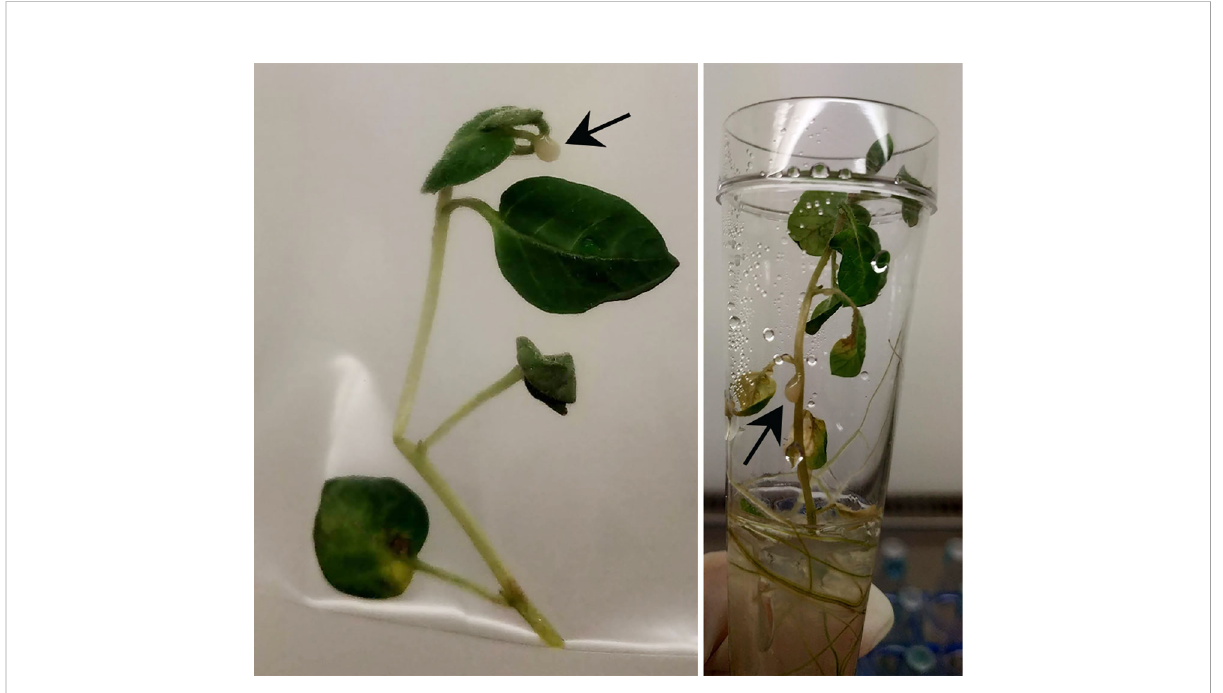
FIGURE 4 In vitro plants infected with Ralstonia solanacearum at 15 dpi; Arrows indicate oozing of bacterial slime, containing high concentrations of